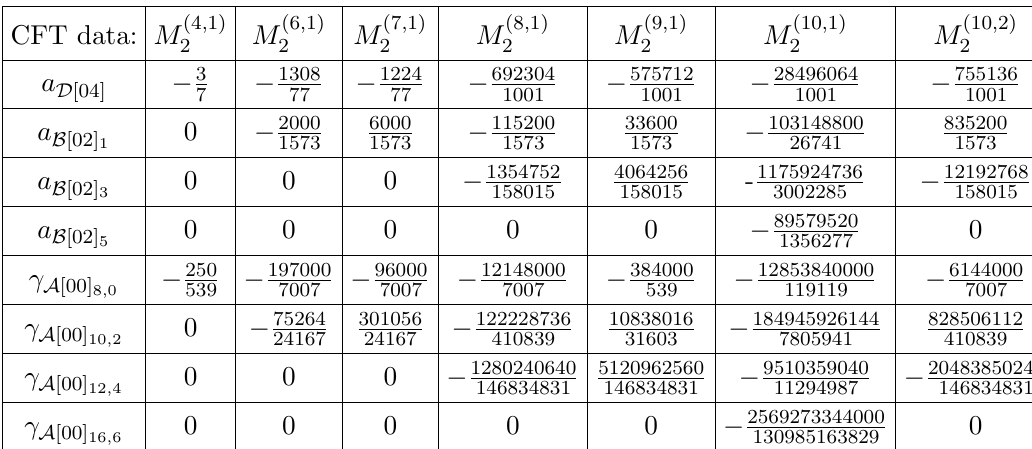
Table 2 . Contributions to the OPE coe(cid:14)cients squared a and anomalous dimensions (cid:13) of various multiplets appearing in S 2 (cid:2) S 2 from the degree p polynomial Mellin amplitudes M ( p;i ) latter are de(cid:12)ned via (2.27) and the reduced Mellin amplitudes f M ( p;i ) should be understood as multiplying B ( p;i ) by comparing to an independent CFT computation of a quantity in the left-hand column, one determines the M-theory amplitude via